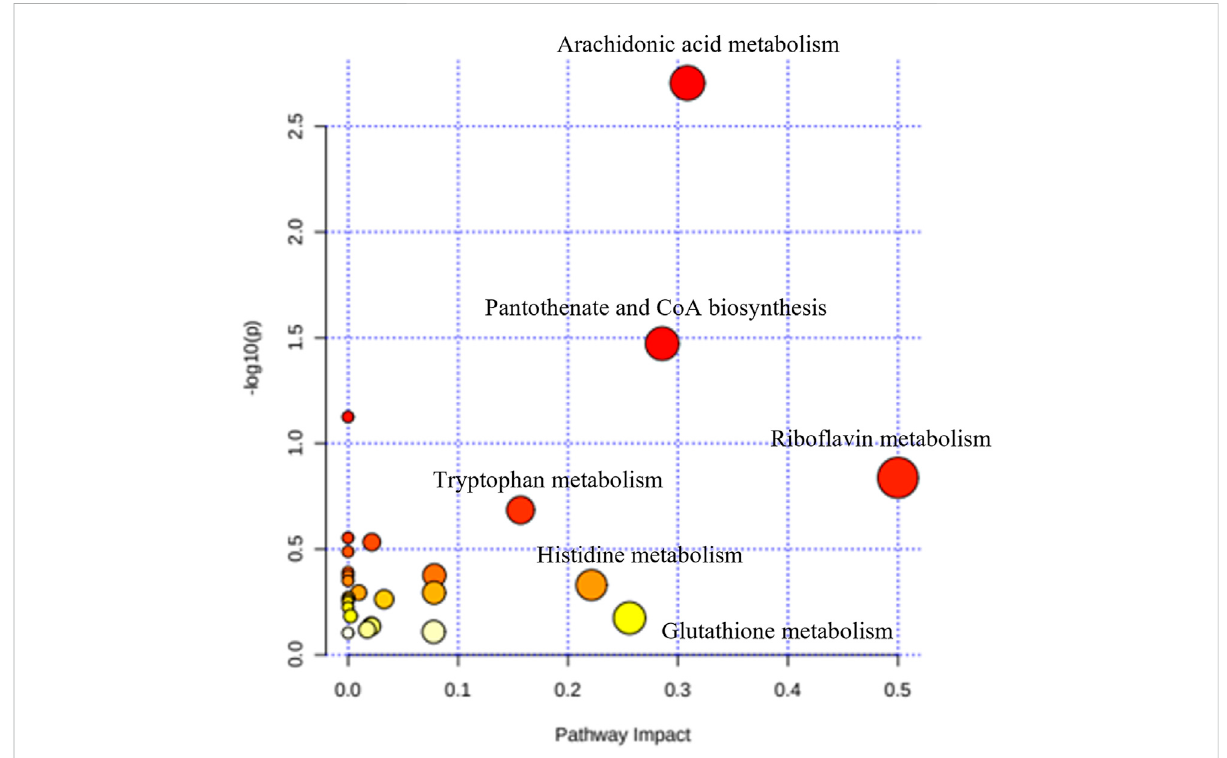
FIGURE 7 Summary of the pathway analysis of the effects of kratom in adolescent rats ’ brain